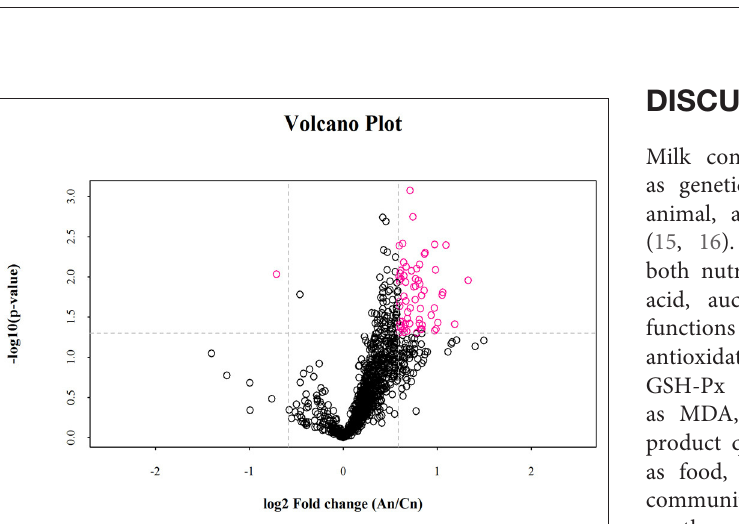
FIGURE 2 | Key differential metabolic pathways between the EUL and CTR groups. This figure aims to find pathways significant changed based on enrichment and topology analysis. The x-axis represents compound numbers, and the y-axis represents enriched KEGG pathways. The colors represent pathway impact values. The numbers to the right of the bars in the graph mean the proportion of differential metabolites in the total number of metabolites in this pathway.